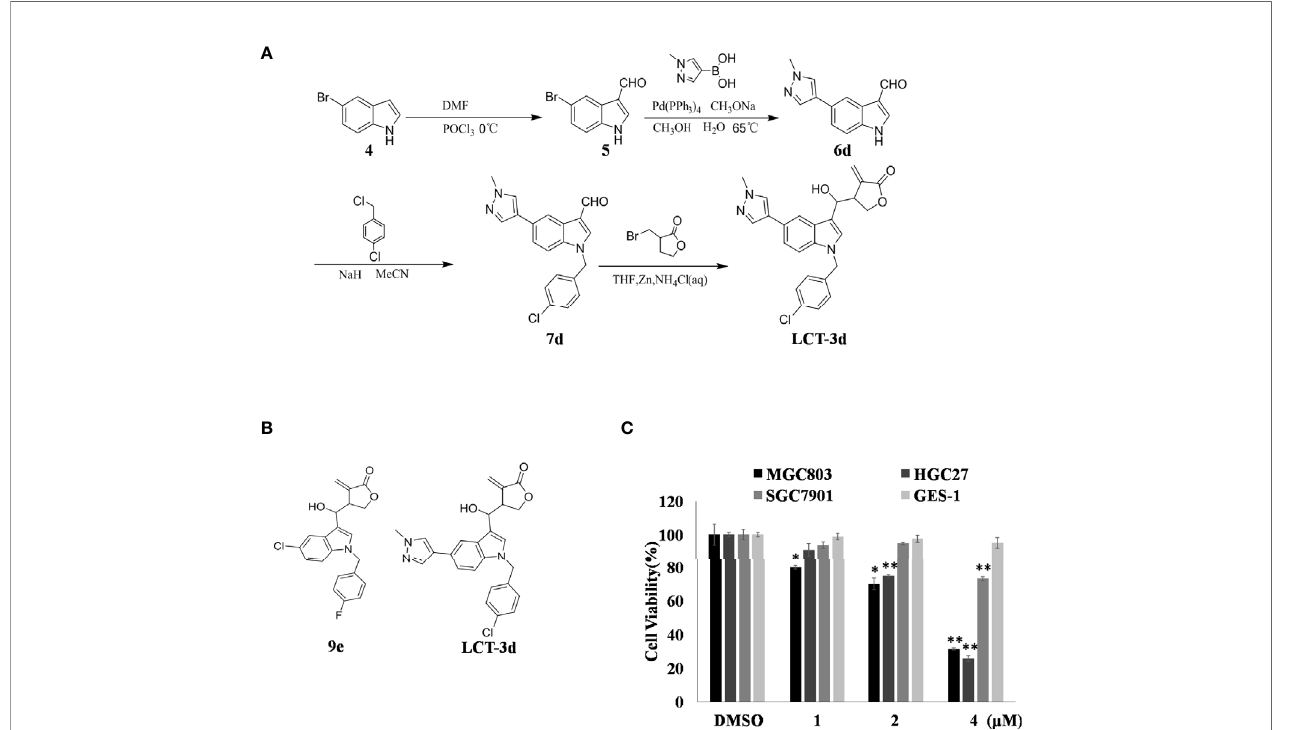
FIGURE 1 | LCT-3d inhibited the cell proliferation of gastric cancer cells. (A) LCT-3d synthetic procedure. (B) Structure of LCT-3d. (C) Cytotoxic effect of LCT-3d on gastric cancer cells measured by MTT assay. Cells were treated with increasing concentration of LCT-3d for 48 h. *P < 0.05, **P < 0.01, signi fi cantly different compared with